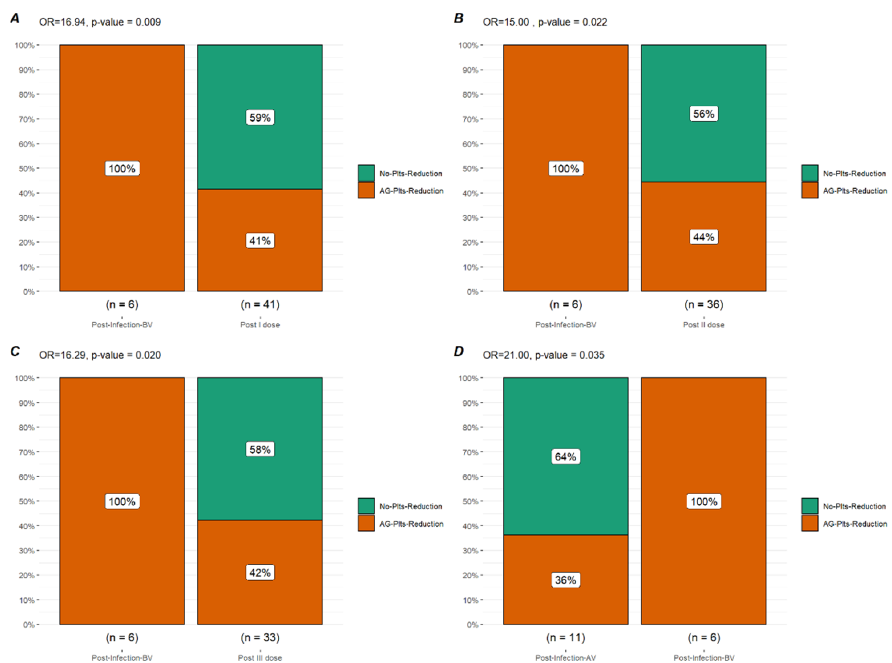
Figure 1. Bar plot of platelet reduction of any grade . Comparison in terms of platelet reduction of any grade (AG-Plt-Reduction) between infection before vaccination (Post-Infection-BV), Post first vaccine dose (Post I dose ( A )), second dose (Post II dose) ( B ), and third dose (Post III dose) ( C ) and post-infection after vaccination (Post-Infection-AV) ( D ).